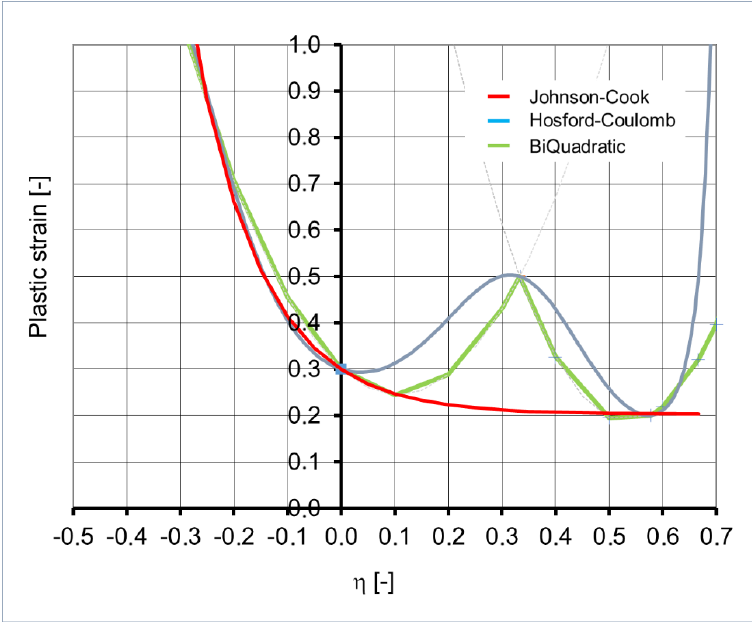
Figure 10. Schematic plots of failure strains vs. triaxiality. Johnson-Cook (red) vs. Modified Hosford-Coulomb (blue) and BiQuad (green).